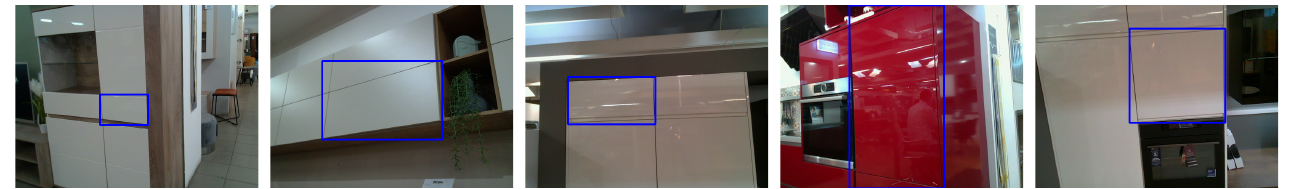
Figure 15. Several examples of objects that are difficult to classify due to their design and viewpoint angle of capture. All framed objects in the images belong to the pull class but were incorrectly classified as